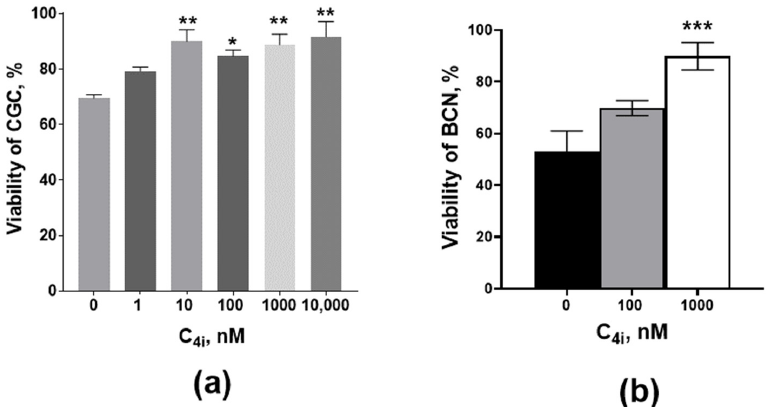
Figure 7. The effect of compound 4i on ionomycin-induced toxicity in a primary culture of rat ( a ) cerebellar granule cells (CGC) and ( b ) brain cortex neurons (BCN). Cell viability was estimated by MTT assay. The ionomycin concentration in all samples of CGC was 3 µ M, and it was 1 µ M in v / v ). * p < 0.05, ** p < 0.01, *** p < 0.001 in comparison with the control (one-way